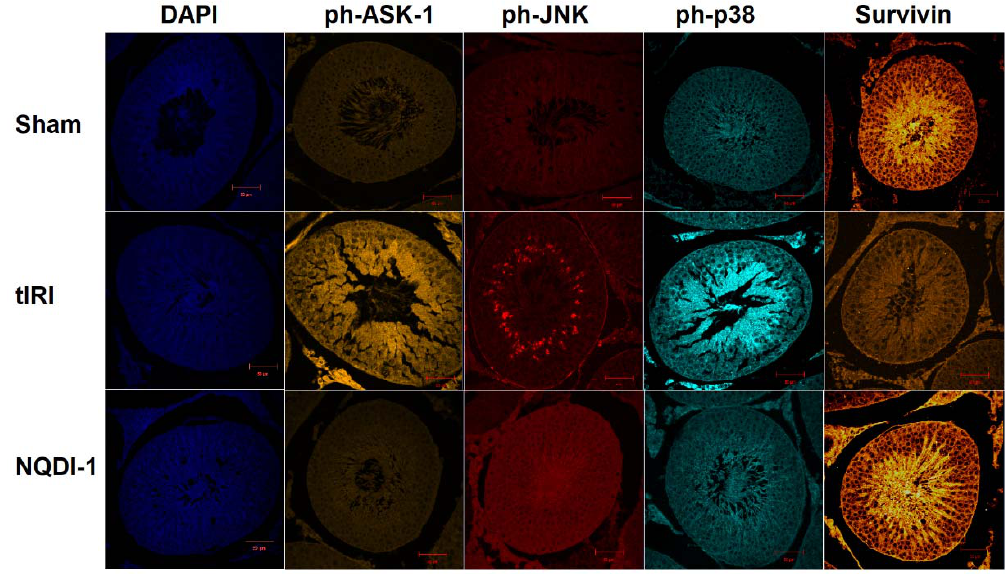
Figure 5. Immunofluorescence (IF) detection of the ph ‐ ASK ‐ 1/ph ‐ JNK/ph ‐ p38/survivin apoptosis signaling pathway. The immuno ‐ expression of the pro ‐ apoptosis kinases ph ‐ ASK ‐ 1/ph ‐ JNK/ph ‐ p38 was increased in spermatocytes in the ipsilateral testes ‐ subjected to tIRI than in sham and after NQDI ‐ 1 treatment ( p ‐ value < 0.0001). The immune ‐ expression of the IAP survivin was localized to spermatids and spermatozoa, however, it was significantly decreased in the tIRI ‐ I group compared to sham and after NQDI ‐ 1 treatment ( p ‐ value < 0.0001). Contralateral testes showed no significant difference between the three animal groups ( P ‐ value > 0.05). NQDI ‐ 1 (10 mg/kg) was i.p. injected 30 min post ischemia. DAPI staining (blue) was carried out for all three animal groups. Fluorescently stained tissue sections (4 μ m) were visualized using the LSM700 confocal microscope. Images were taken at 40x magnification with a scale bar of 50 μ m.